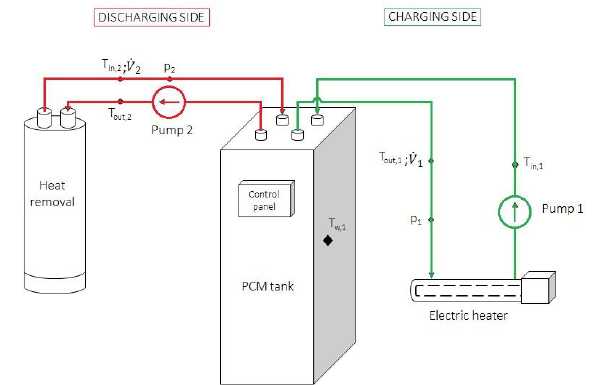
Fig. 3. Graphic scheme of the test stand at Institute of Thermal Technolo- gy, Silesian University of Technology, Gliwice